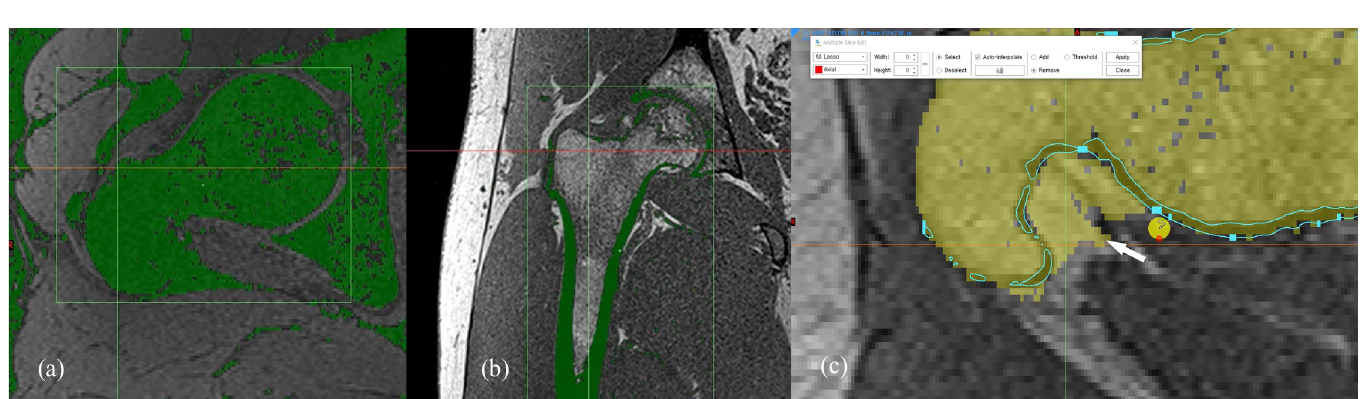
Fig 2. Manual segmentation process of 3D-MRI model. Using a low pass filter, bone structure can be extracted from the fat suppressed MR image, along with fatty tissues, tendons, and ligaments (a). Using the in-phase image obtained in the Dixon method, the bony cortex or subchondral bone plate can be extracted by using low pass filter (b), unlike with the water excitation method. The extracted boundary of the cortex or subchondral bone plate served as a guideline (blue line) between the osseous anatomy and overlying subcutaneous fat (white arrow) during the bone segmentation (c).